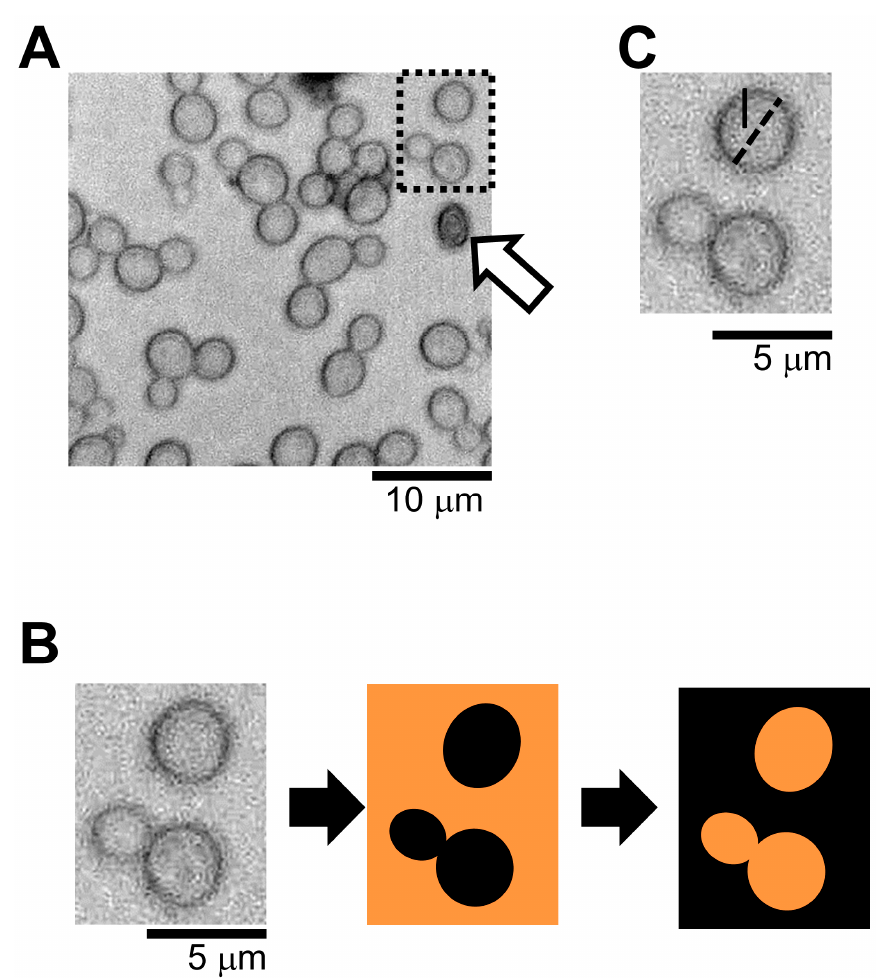
Figure 1. Image analysis of cells. ( A ) shows the overall image. The arrow indicates densely stained and dead cells ( B ) is an enlargement of a portion of ( A ) surrounded by a dotted line. The image is inverted after adjusting the image brightness ( C ) shows the length scale in this magnified section. The fine length l is the longest part of the cell.